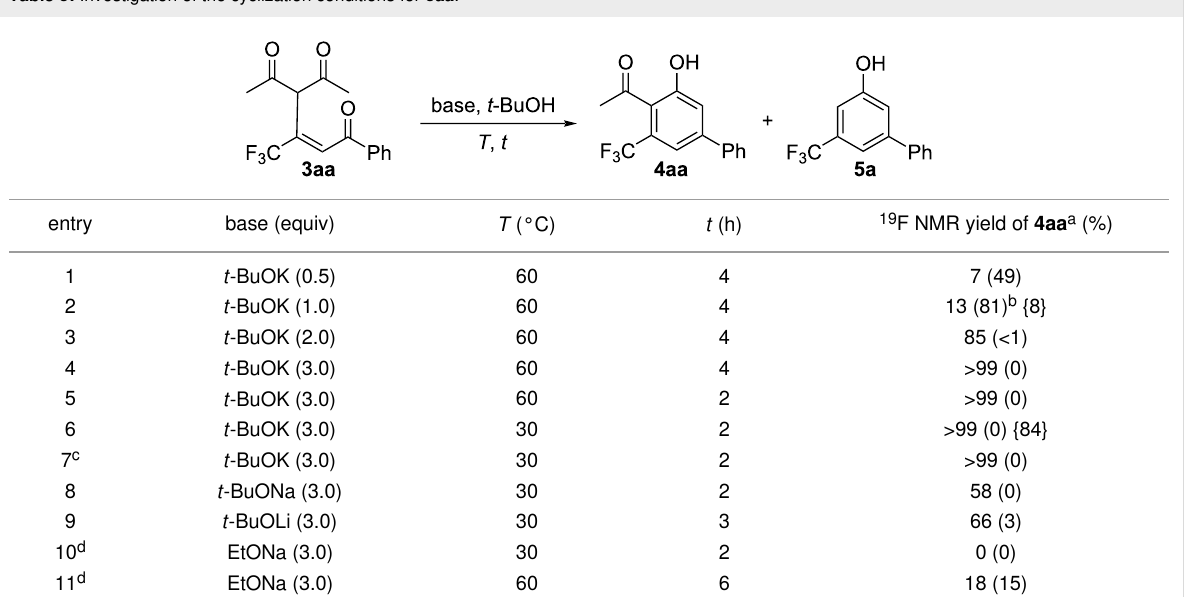
Table 3: Investigation of the cyclization conditions for 3aa